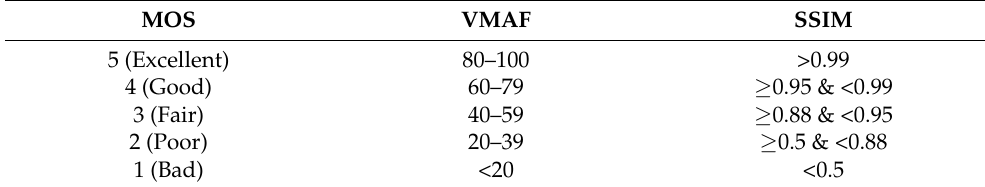
Table 2. VMAF and VMAF to MOS